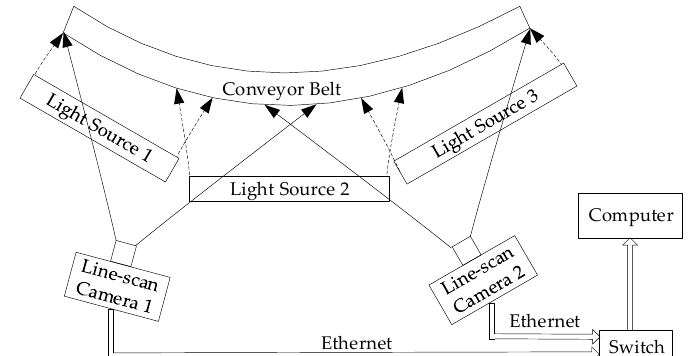
Figure 1. Schematic diagram of multi-view conveyor belt surface fault online detection system.